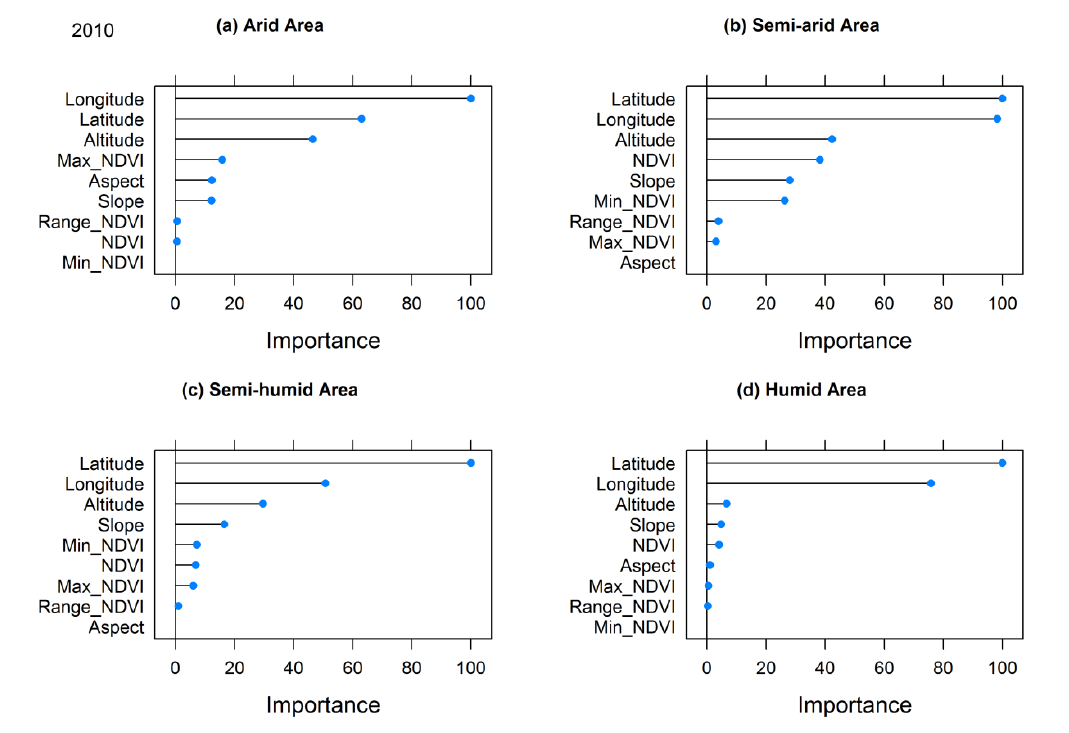
Figure 6. Importance of geospatial predictors for precipitation downscaling in ( a ) arid; ( b ) semi-arid; ( c ) semi-humid; and ( d ) humid regions for the years of 2001 and 2010, illustrated by the MDG of attributes as assigned by